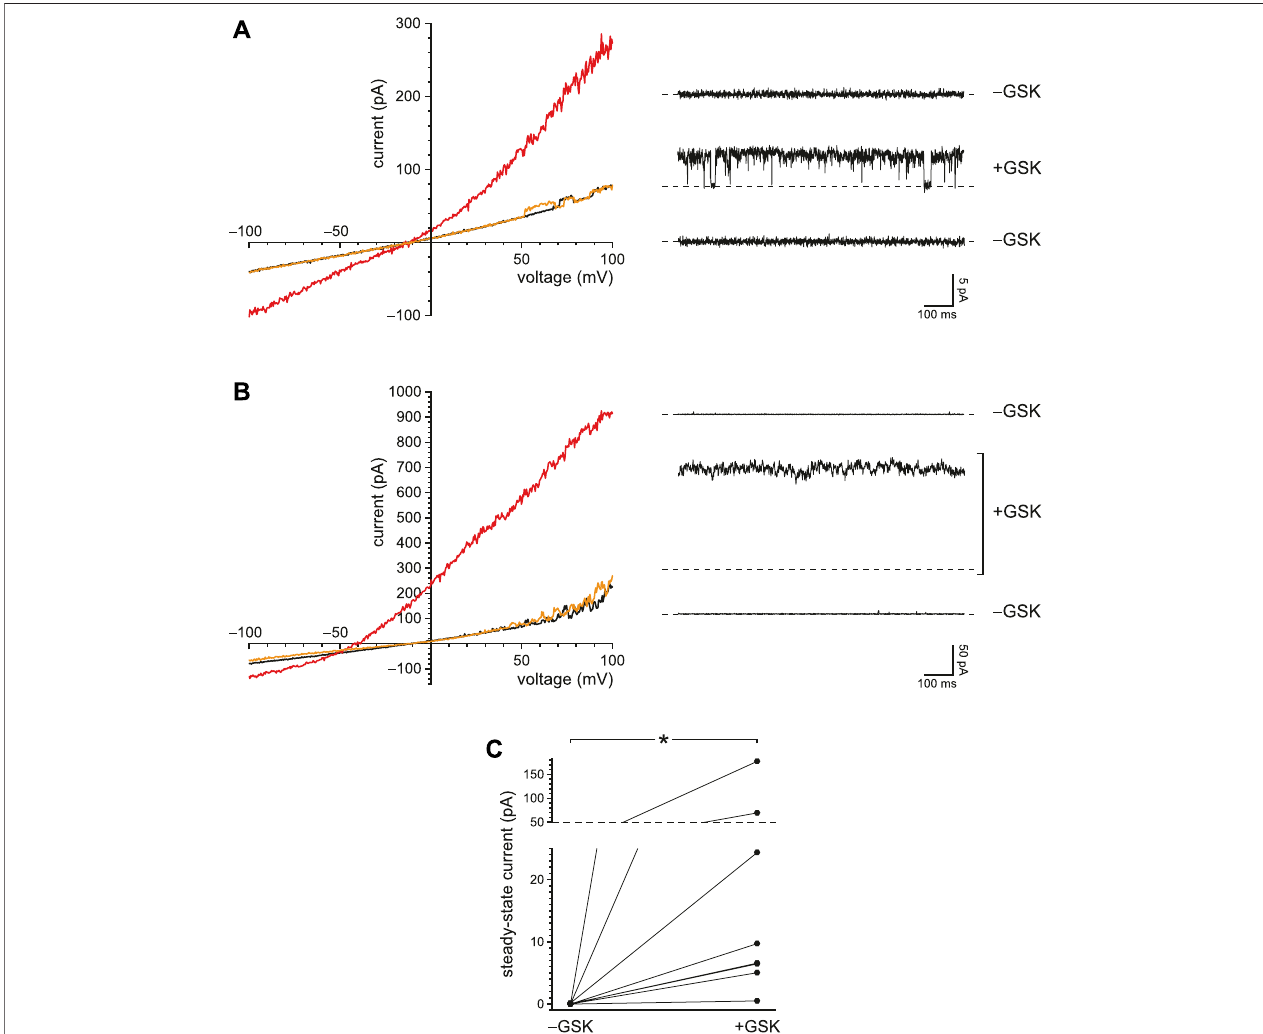
FIGURE9| ActivationofPC2secondarilytoaCa 2+ in fl uxthroughTRPV4channels. (A) InasingleciliumwithjustoneactivePC2channel,theciliarycurrent-voltage relation(left)wasmeasuredintheabsenceoftheTRPV4agonistGSK1016790A(black),initspresence(50 nM,red),andagaininitsabsence(orange).Steady-statePC2 activity at − 5 mV was reversibly activated by GSK1016790A (right). For each of the three recordings, a dashed line is shown at the level of the leak current (3.6 pA). The sameciliumwasusedfortheleftandright fi gures. (B) Arepeatoftheexperimentshownin (A) butusingaciliumwithmultiplePC2channels.Thedashedlinesagain show the leak current (4.7 pA). (C) Paired mean PC2 currents at − 5 mV after subtraction of leak currents in 8 cilia, each tested in the absence and presence of GSK1016790A. In all parts of this fi gure, Ca 2+ was buffered with 0.25 mM BAPTA. * p = 0.0078.